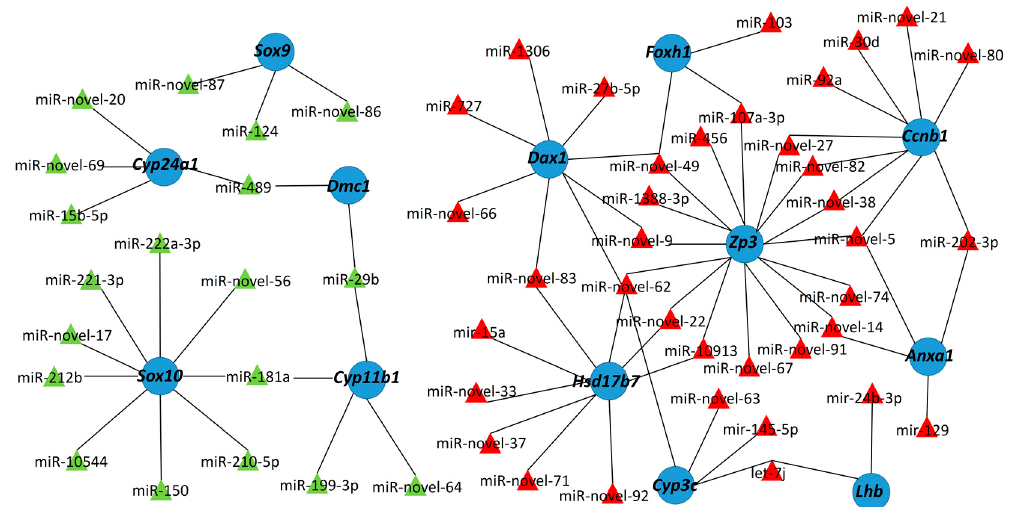
Figure 8. Regulatory network showing interactions between sex-related target genes and DE miRNAs. The testis- and ovary-biased miRNAs are represented by red and green triangles, respectively, while the sex-related target genes are represented by blue circles.